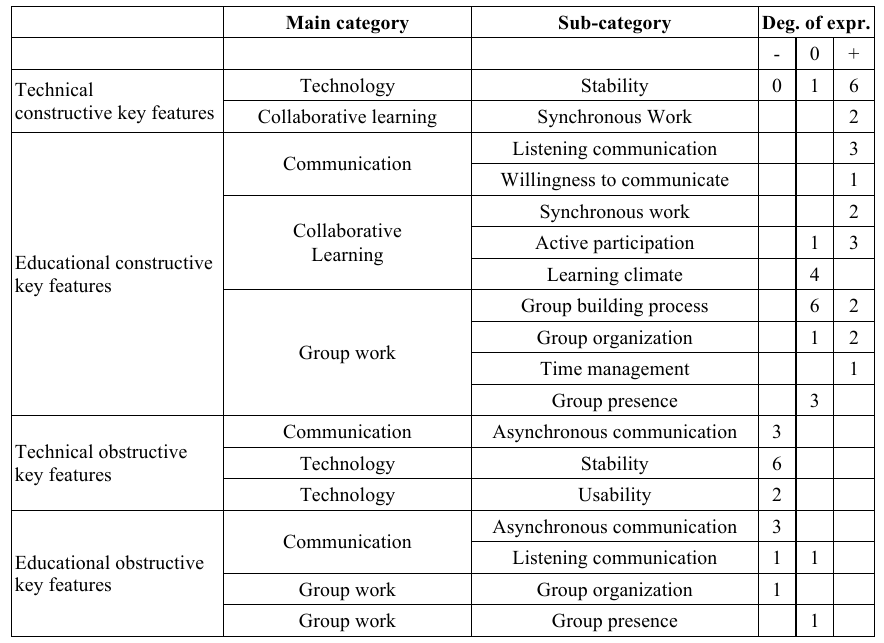
Table 6. Qualitative analysis Course